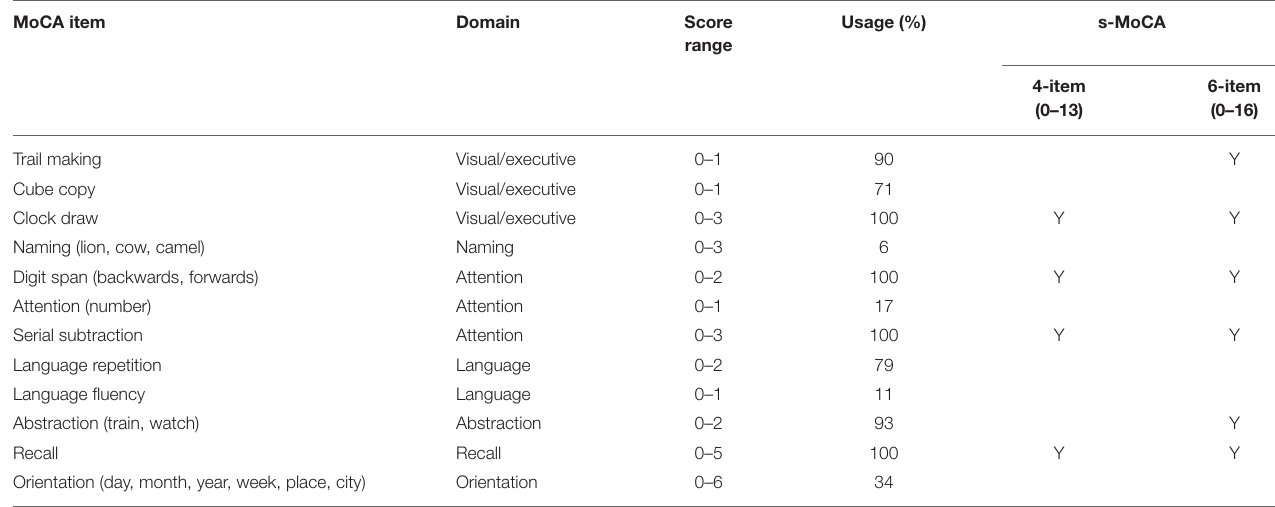
TABLE 1 | Item usage and selection in the CAT for s-MoCA ( n =